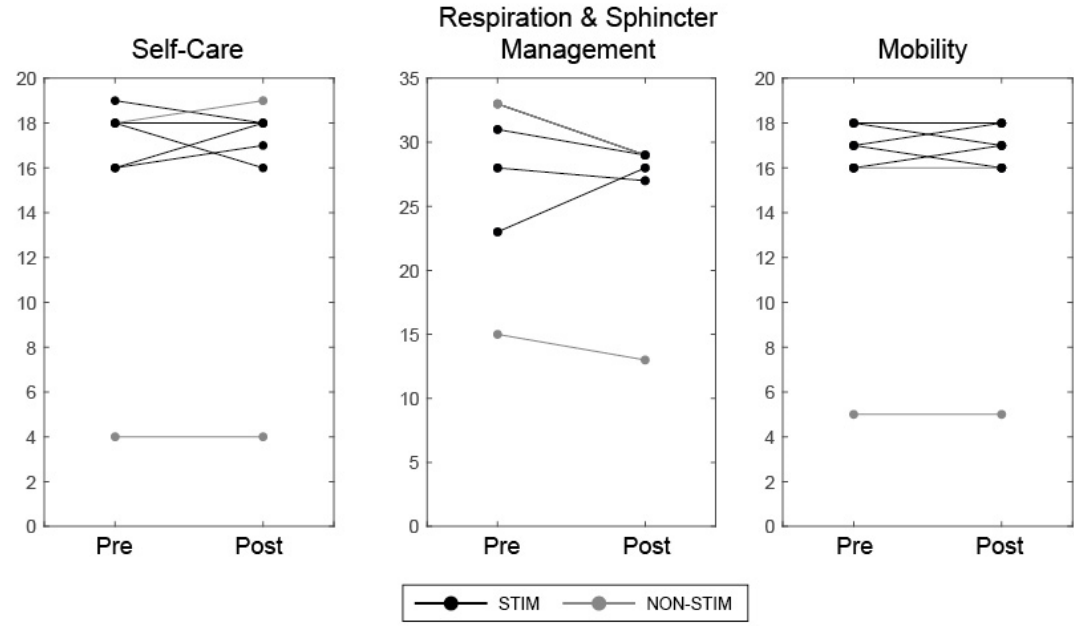
Figure 9. SCIM scores across three sub-categories before (pre) and after (post) the intervention for participants in STIM (black) and NON-STIM (grey) groups.